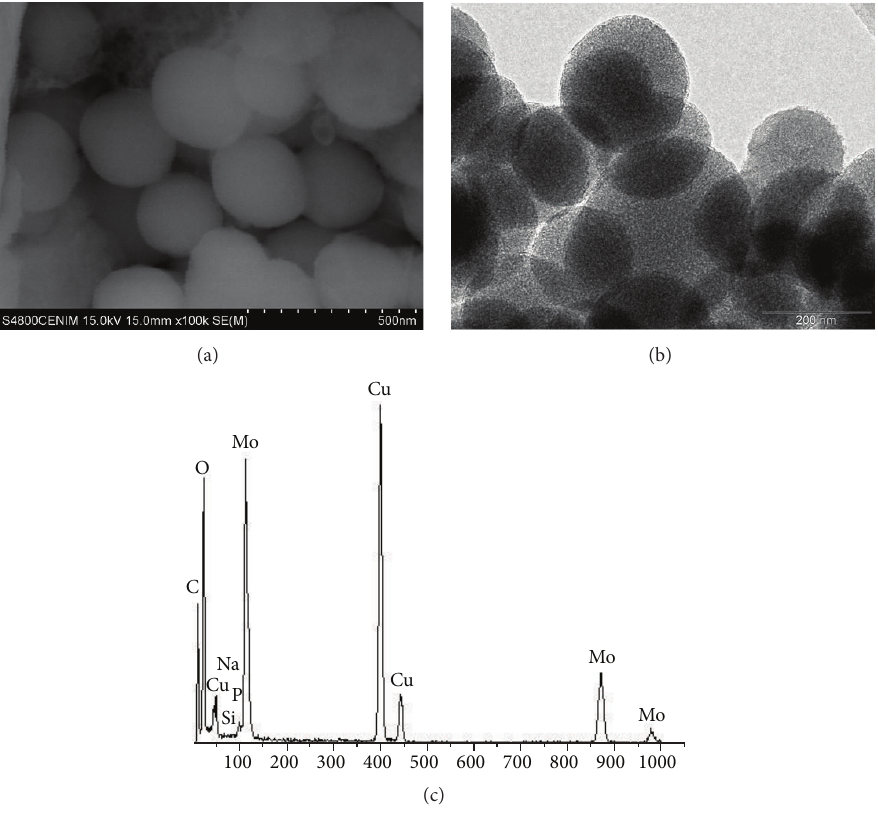
Figure 3: SEM image (a), TEM image, (b) and EDX analysis (c) of the SiO 2 mesoporous nanoparticles after loading with sodium phospho- molybdate.